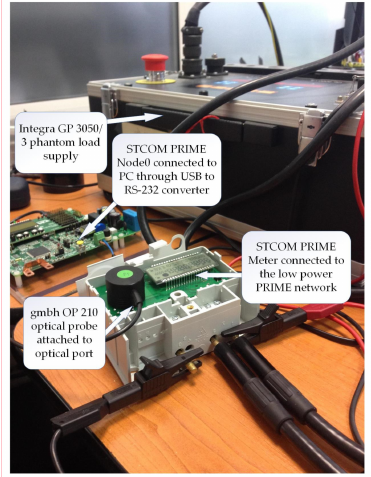
Figure 4. STCOM smart meter connected to PLC concentrator and to optical probe